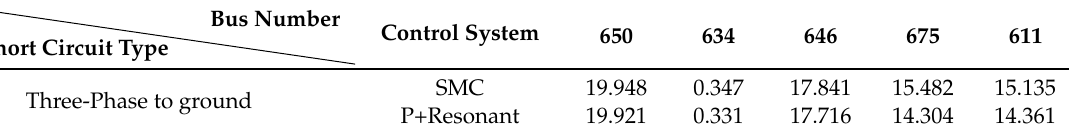
Table 3. Domain of bus voltage due to different short circuits in the DSTATCOM-compensated system.